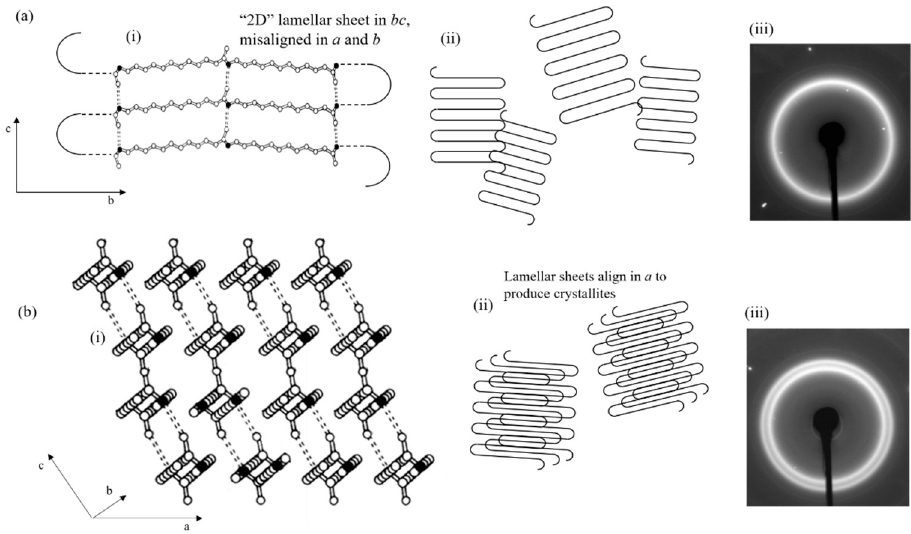
Figure 11. ( a ) Lamellar sheet in Nylon-12: (i) aligned chains bonded in the c -axis by H-bonds, (ii) conceptual diagram of misoriented lamellae, (iii) the resulting di ff raction pattern with a single ring observed due to bulk isotropic alignment in c . ( b ) Lamellar sheets form energetically favourable planes along the a -axis, leading to a more complete unit cell and causing the emergence of the 200 di ff raction ring. (i) Unit cell in full lamellar form, (ii) crystallites formed as a result, and (iii) the resulting di ff raction pattern. Basic unit cell schematic of Nylon-12 according to Inoue and Hoshino [8]. Based on our observations, a possible picture of the internal structure evolution is proposed